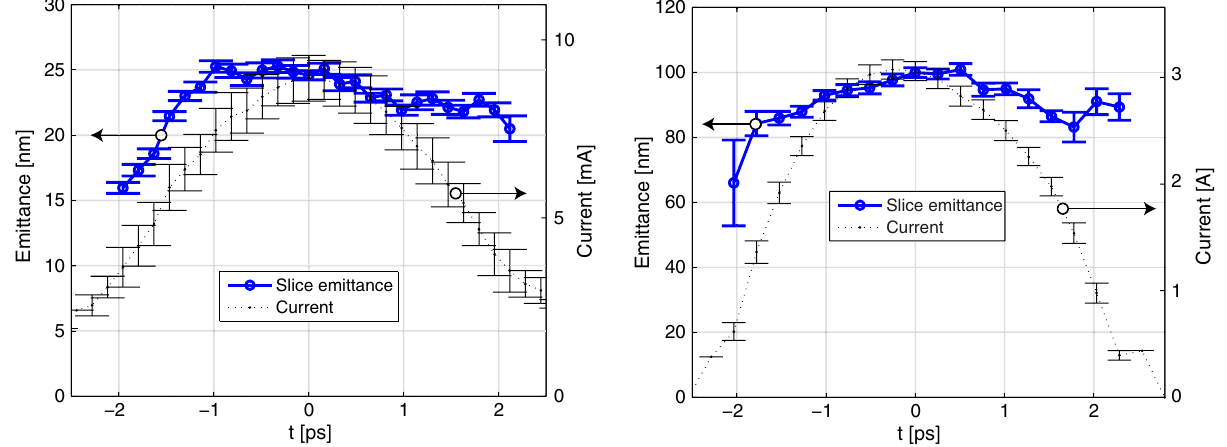
FIG. 7. Slice emittance measurement of a 30 fC beam (left) and of a 10 pC beam (right). The plot shows the charge distribution (black curve) as well as the emittance of the slices (blue